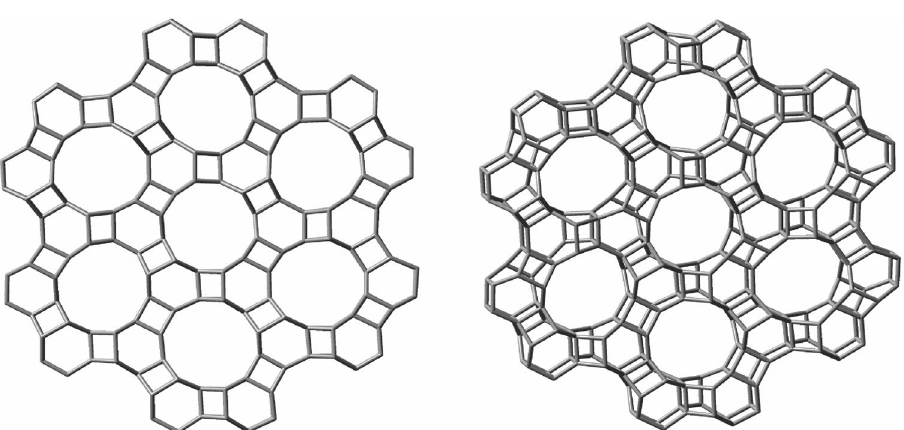
Figure 15. Two perspectives of compound C 288 H 144 obtained by square face-fusions of 24 units of nugget 16 .